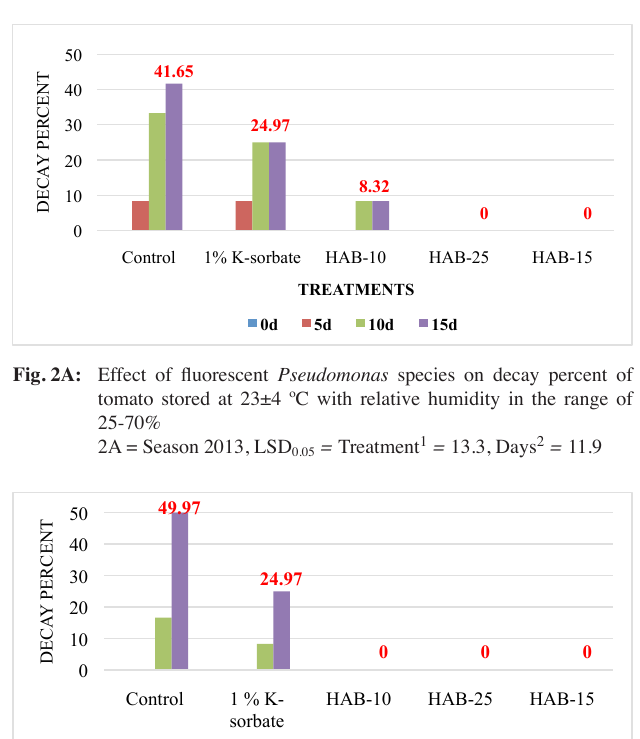
Fig. 2A: Effect of fluorescent Pseudomonas species on decay percent of tomato stored at